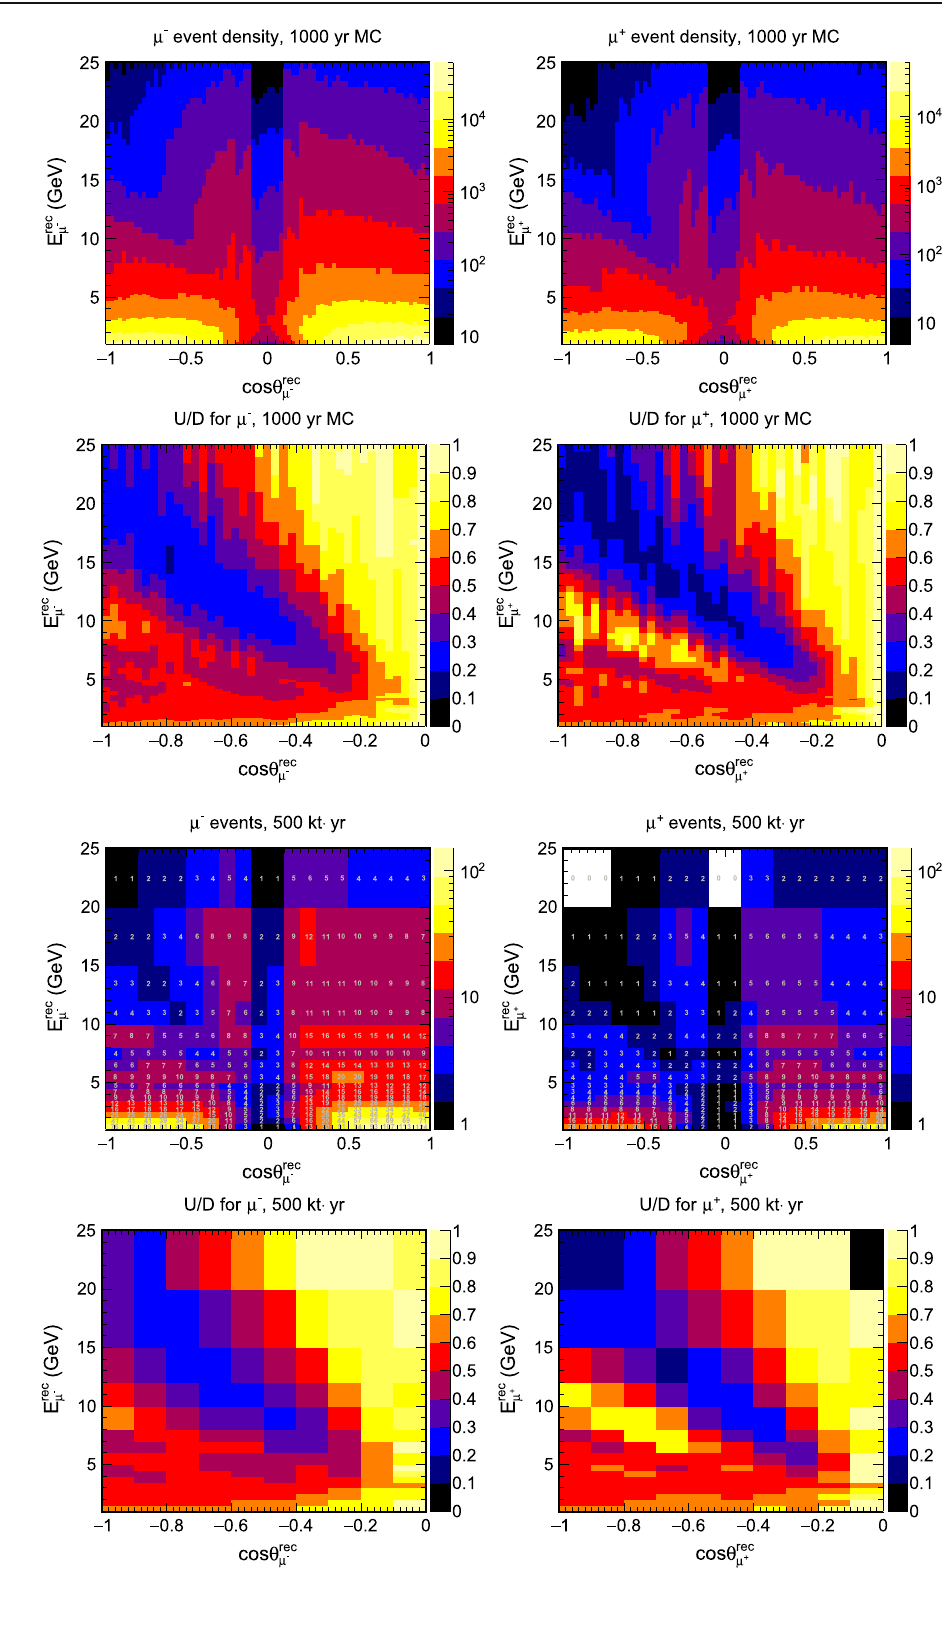
Fig. 7 The distribution of event density (upper panels) and U/D ratio (lower panels), for μ − (left panels) and μ + (right panels), in the ( E rec μ , cos θ rec μ ) plane, obtained using the 1000-year MC sample. We use the oscillation parameters given in Table 1. Note that the event density in the upper panels has units of [GeV − 1 sr − 1 ], and is obtained by dividing the number of events in each bin by (2 π × the bin area), i.e.by (2 π(cid:3) E rec μ (cid:3) cos θ rec μ ). Here (cid:3) E rec (cid:3) cos θ rec μ and μ are the height and the width of the bin, respectively. Note that the U/D( E rec μ , cos θ rec μ ) is defined only for cos θ rec μ < 0 (see Eq. 4)